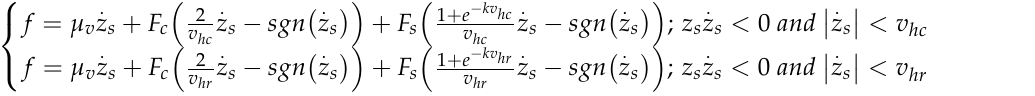
Figure 2. Dynamic seal friction model considering Stribeck, hysteresis, and asymmetric behavior. The friction force within the linear transition band, ‘compression’ and ‘extension’ strokes, respectively, as seen in Figure 2 (the arrows indicate the directions of strut motion), describes the asymmetric hysteresis effect as the direction of . z s < 0) and can be expressed as velocity changes ( z s